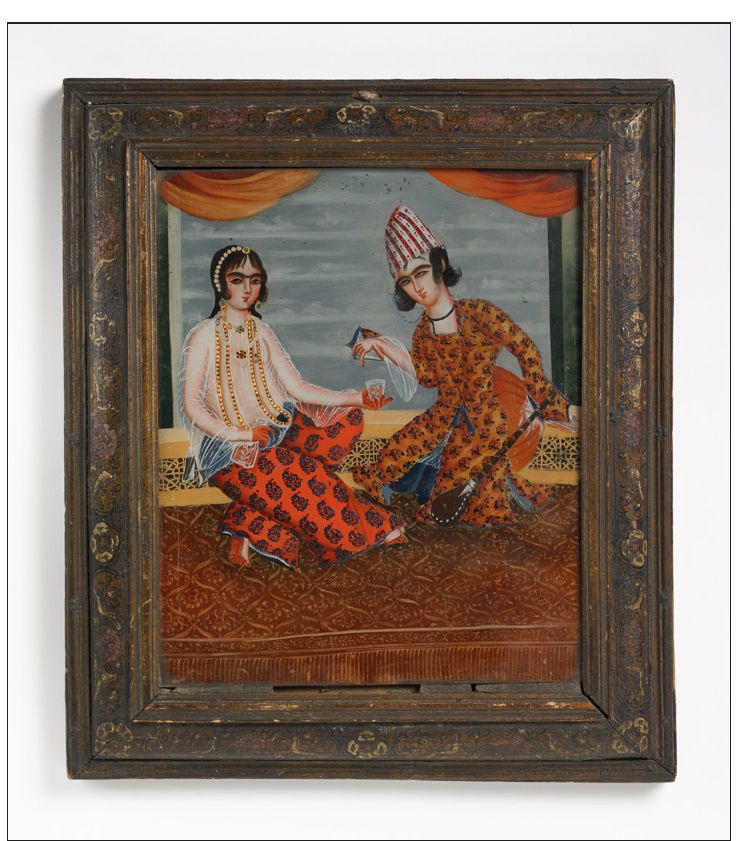
Fig. 8 : Reverse painting on glass, pigment, glass, wood, Iran, nineteenth cen- tury. M183A, given by Miss E. G. Tanner in 1926. © Holburne Museum, Bath. Photo: